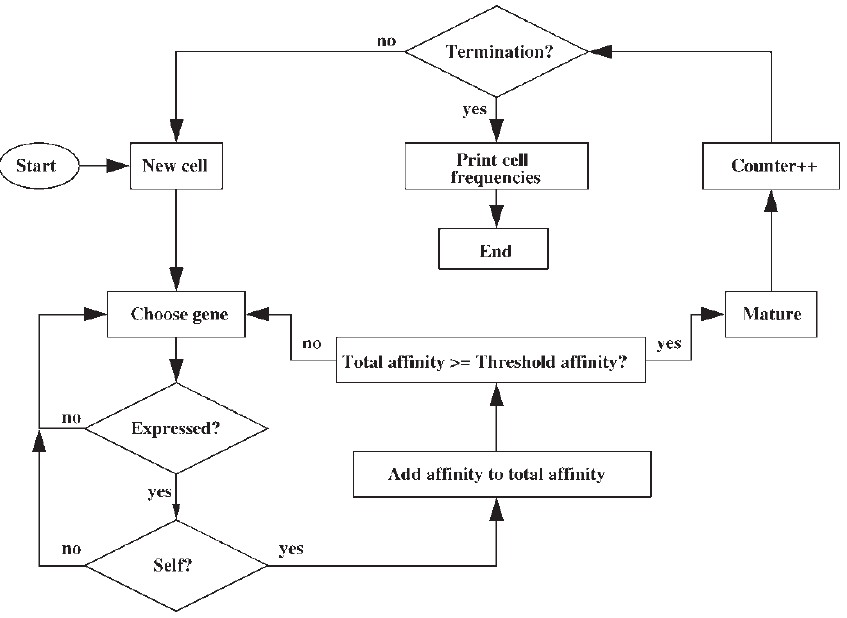
FIGURE 4 Flow chart of the sequential simulation. (The program is available from the authors upon